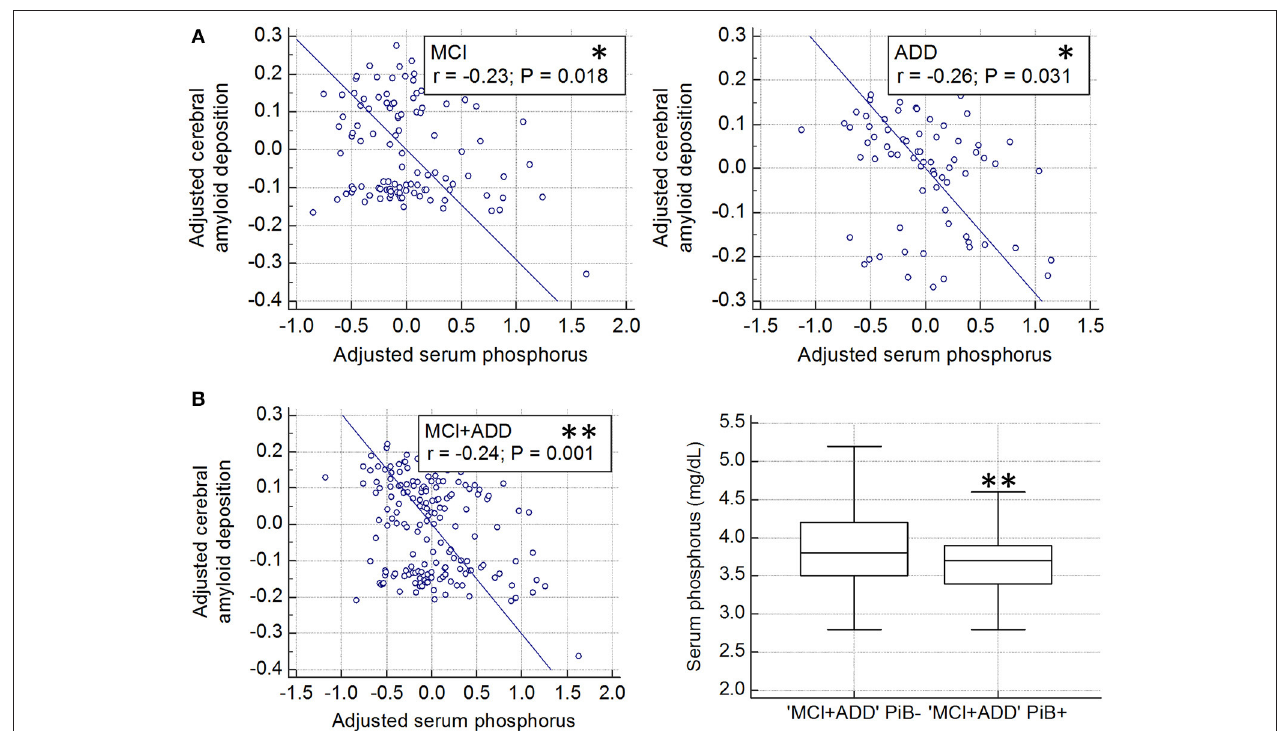
FIGURE 1 | Association cerebral amyloid deposition with serum phosphorus levels in cognitively impaired subjects (A) Partial correlation plot shows the relationship between global cerebral amyloid deposition (SUVR) and serum phosphorus after controlling for age and sex, in both MCI and ADD (MCI, * p < 0.05; ADD, * p < 0.05). Global cerebral amyloid burden was natural log transformed to normalize variance. (B) Partial correlation plot in whole cognitively impaired subjects (MCI plus ADD, ** p < 0.01, left graph). Global cerebral amyloid burden was natural log transformed. Comparison of serum phosphorus levels between PiB + and PiB − in whole cognitively impaired subjects (MCI plus ADD, ** p < 0.01; P –values were obtained by ANCOVA comparing adjusted mean after controlling for the effect of age and sex, right graph). PiB, Pittsburgh Compound B; MCI, mild cognitive impairment; ADD, Alzheimer’s disease dementia; ± , PiB positivity; SUVR, standardized uptake value ratio.